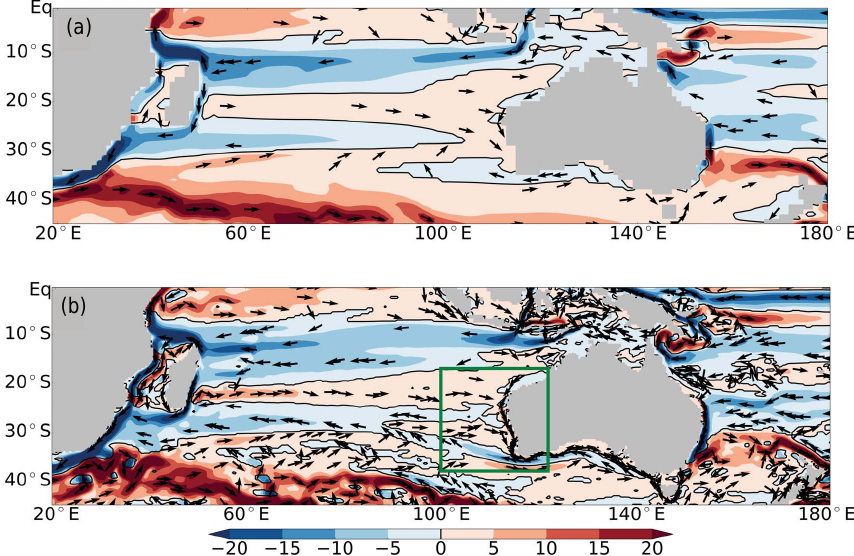
Figure 4. Steady-state horizontal velocities averaged over the top 200 m (cms − 1 ) from the GCM simulations. (a) Coarse resolution (1.0 ◦ ), (b) eddy-resolving resolution (0.1 ◦ ). Positive values indicate an eastward component. Unit vectors are added at local maxima to show the direction of the flow. The green box indicates the area shown in Fig. 5a.